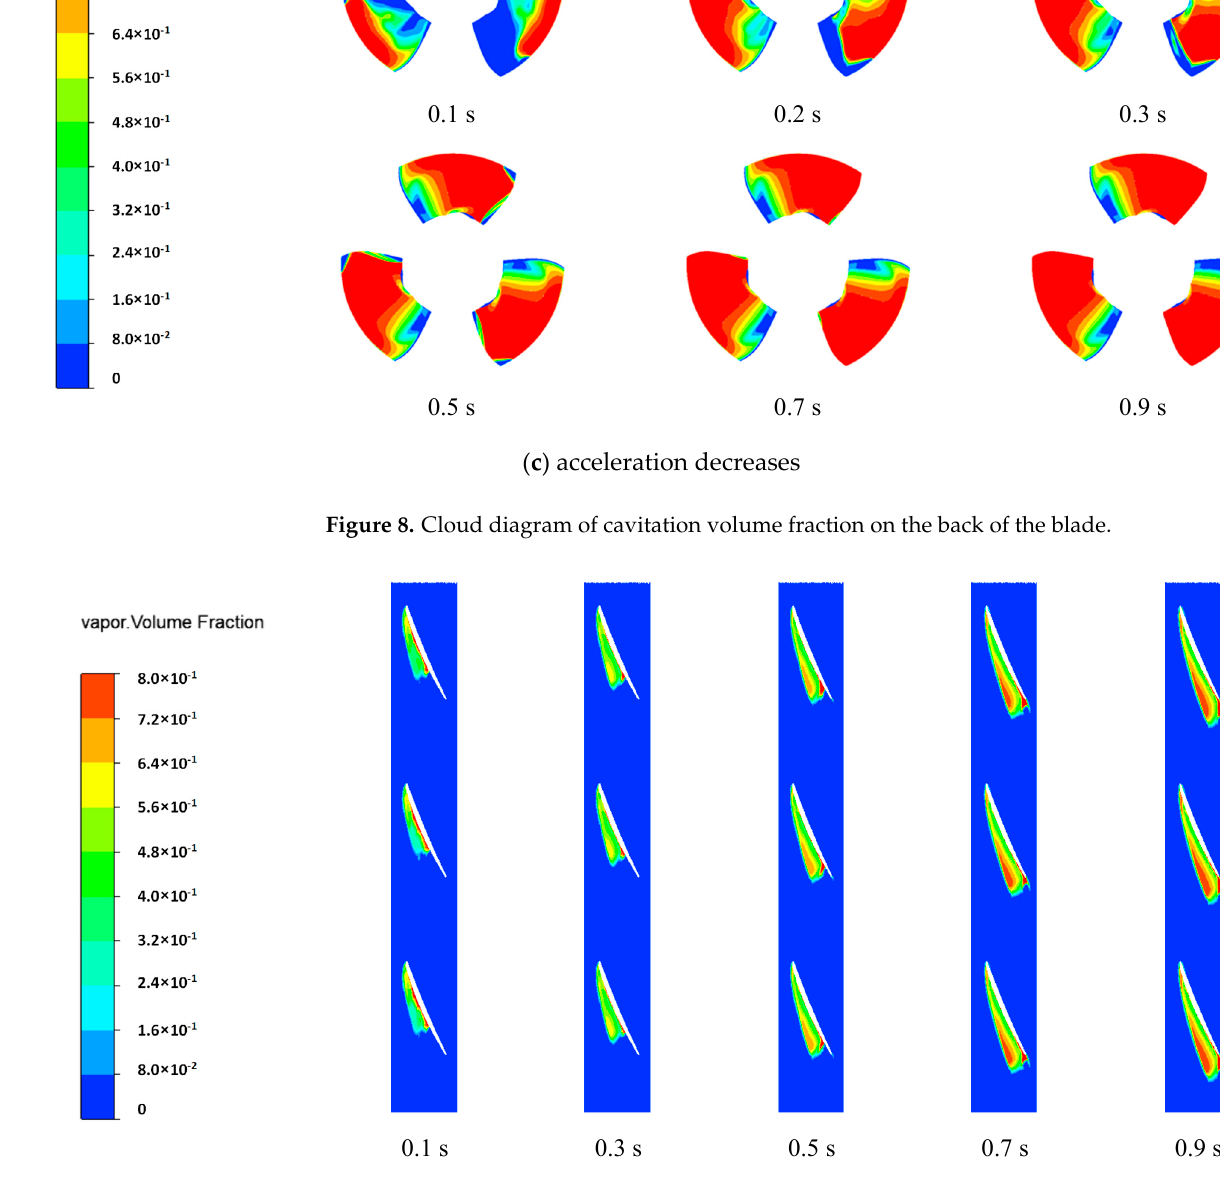
Figure 8. Cloud diagram of cavitation volume fraction on the back of the blade.